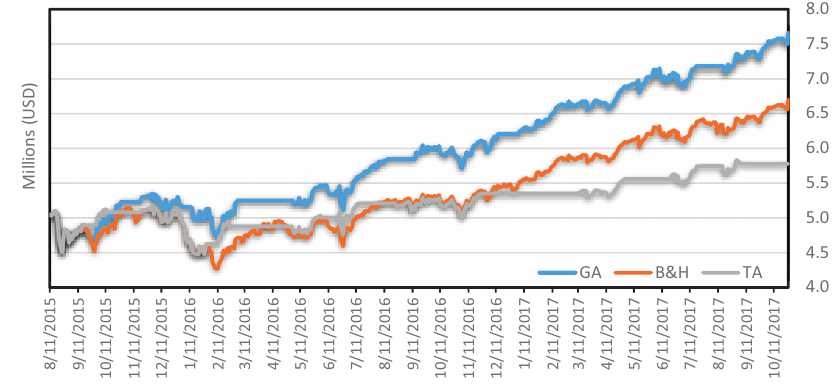
Figure 2. Comparative of cumulative yield of investment strategies GA, B&H and